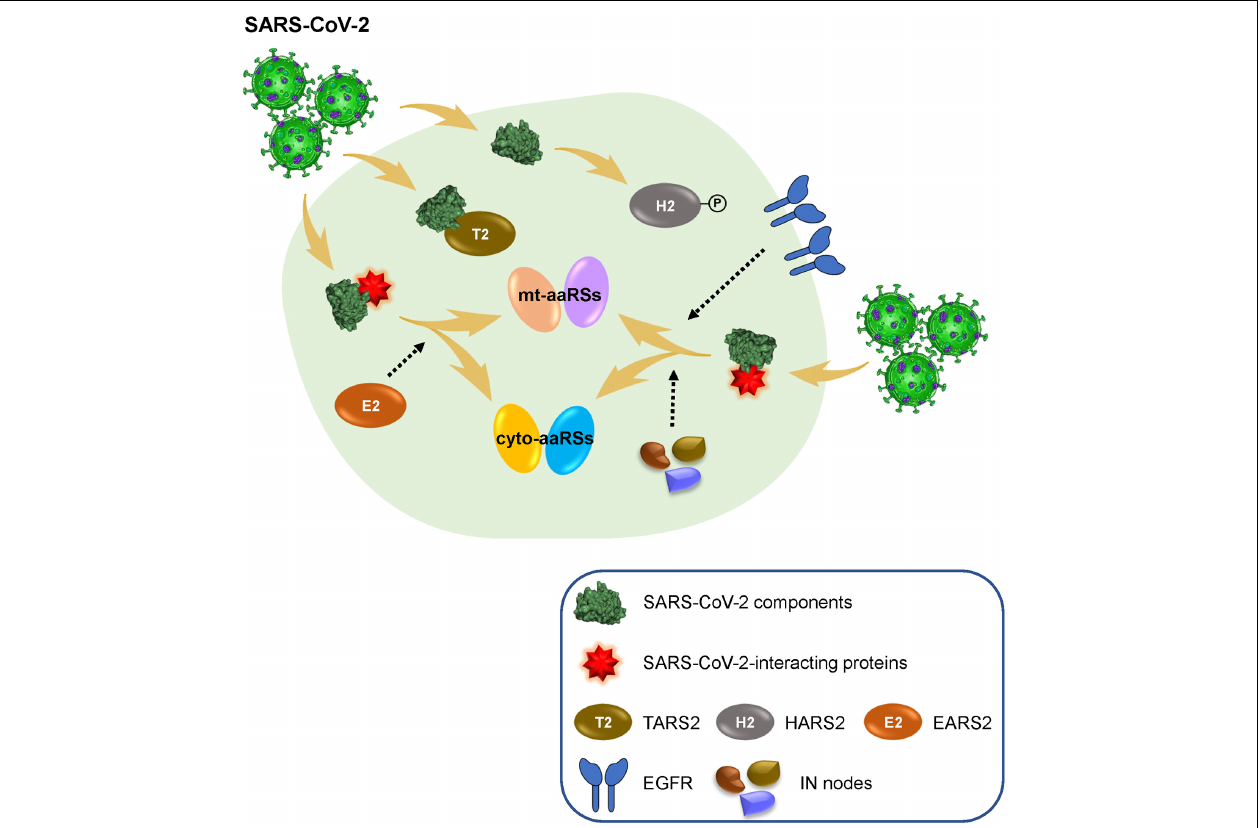
FIGURE 6 | Human aminoacyl-tRNA synthetases (aaRSs) involved in SARS-CoV-2 infection. SARS-CoV-2 infection leads to obvious changes of human mt-aaRSs, in which, TARS2 physically interacts with SARS-CoV-2 M protein; the phosphorylation of HARS2 is significantly increased; and EARS2 serves as a key intermediate (IN) node mediating SARS-CoV-2 infection in the host. In addition, newly identified IN nodes such as EGFR fill the gap between the first interactors in response to SARS-CoV-2 and the downstream aaRSs, reflecting vital roles of certain aaRSs during SARS-CoV-2